Question: What caption would you write for this figure?
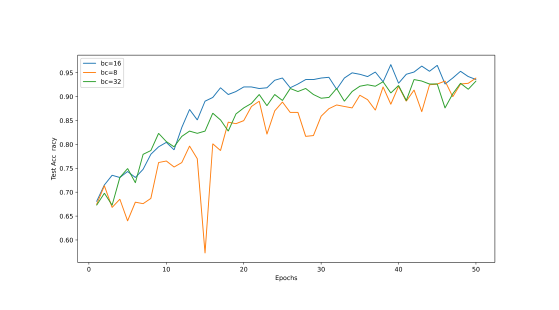
Answer: Accuracy at different batch sizes.